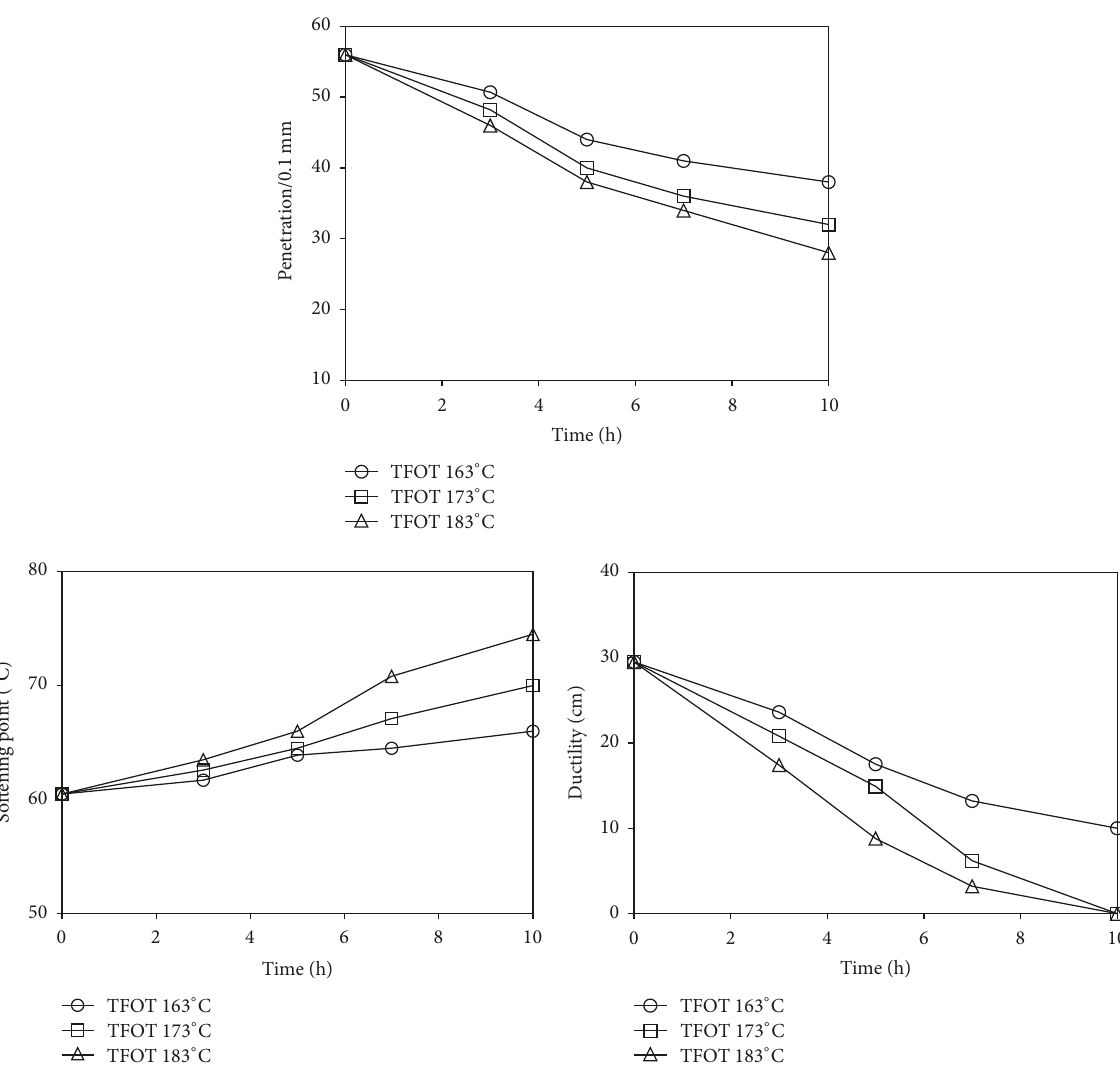
Figure 1: Correlation of three major indexes with aging time.